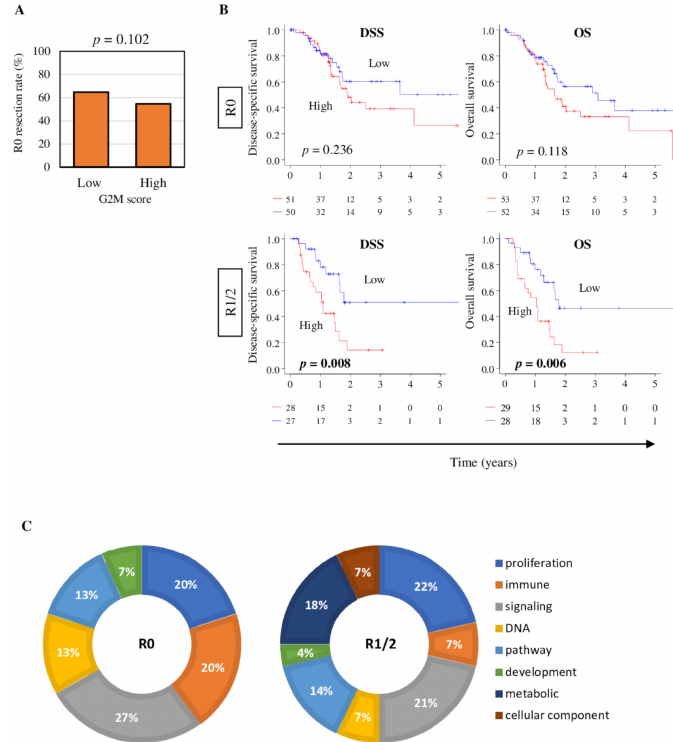
Figure 6. Association between G2M pathway score and resection status and respective survival in the TCGA cohort. ( A ) Achievement rate of R0 resection between low and high G2M pathway score in the TCGA cohort. p -value was determined by two-tailed fisher’s exact test. ( B ) Kaplan–Meier survival plots comparing low and high G2M score tumors in R0 or R1 / 2 resection groups, for OS and DSS in the TCGA cohort. High and low score groups were divided by the median value. Log rank test was used to compare between high and low score groups in Kaplan–Meier plots. ( C ) Pie charts of the categories of Hallmark gene sets for which significant enrichment (NES > 1.5 and FDR < 0.25) was observed in high G2M score compared to low G2M score tumors in R0 and R1 / 2